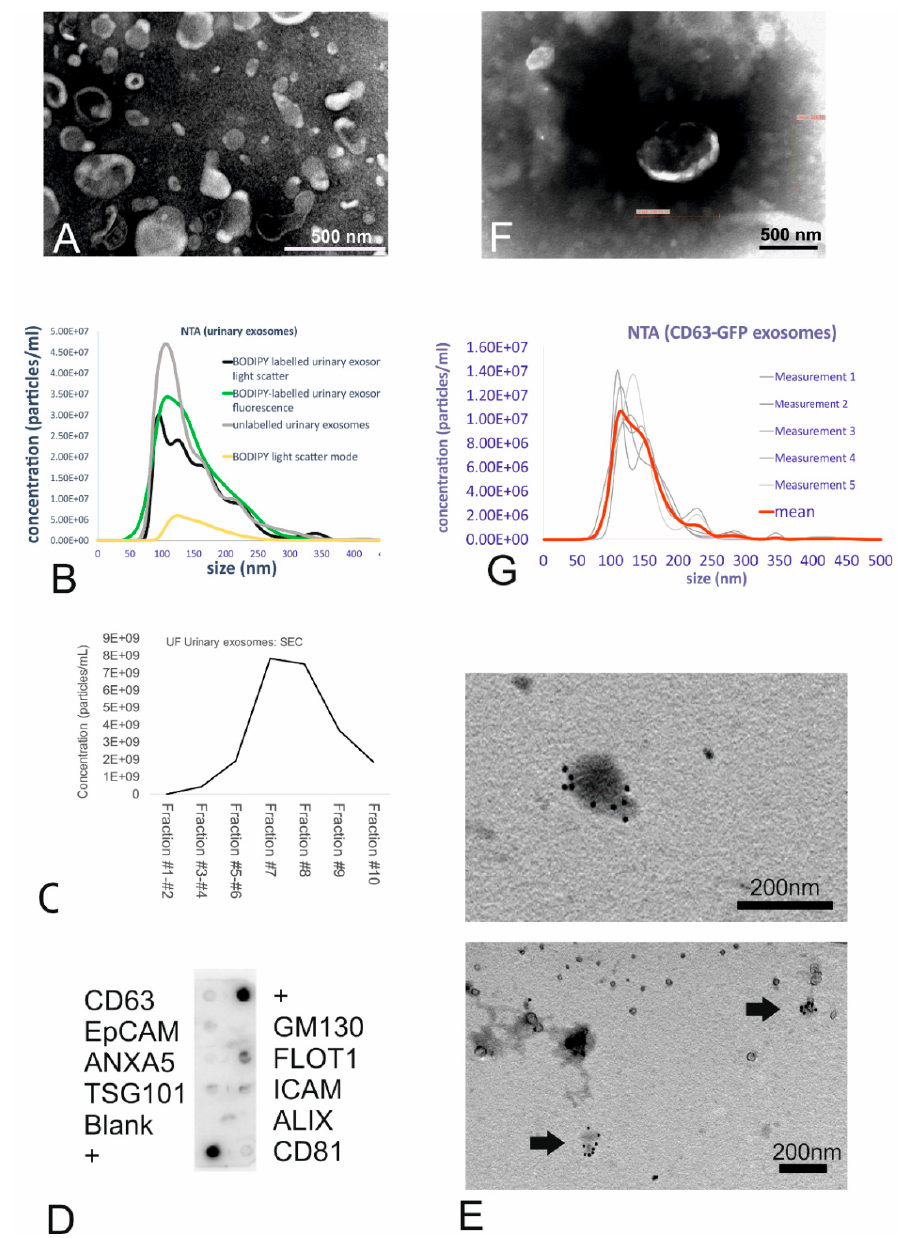
Figure 1. Isolation, characterization, and labelling of the urinary small extracellular vesicles (EVs). ( A ) TEM images of the small EVs obtained using ultrafiltration (UF). UF samples showed intact cup-shaped double-membrane structures. Scale bar = 0.5 µ m. ( B ) Nanoparticle tracking analysis (NTA) showing the size distribution of the urinary small EVs (both unlabelled and BODIPY-labelled). The graph shows the concentration on the Y-axis and size distribution on the X-axis. ( C ) Size-exclusion chromatography of unlabelled urinary small EVs revealed small EVs (peaks in the particle count graph) in fractions 6–8. ( D ) Exo-Check antibody array showing the presence of the following exosomal markers in the ultrafiltrated small EV urinary samples: FLOT1, ICAM, TSG101, CD81, and CD63. ( E ) Immunogold TEM (urinary small EVs) showing the presence of CD63 tetraspanin, an exosomal marker, in vesicles in the UF sample. ( F ) TEM of the ultrafiltrated medium collected from the CD63-GFP transduced human fibroblasts shows some structures displaying typical exosome features. Scale bar = 0.5 µ m. ( G ) NTA of the genetically tagged fibroblast-derived small EVs: Analysis displays the light-scatter results (small EV mean size of 146